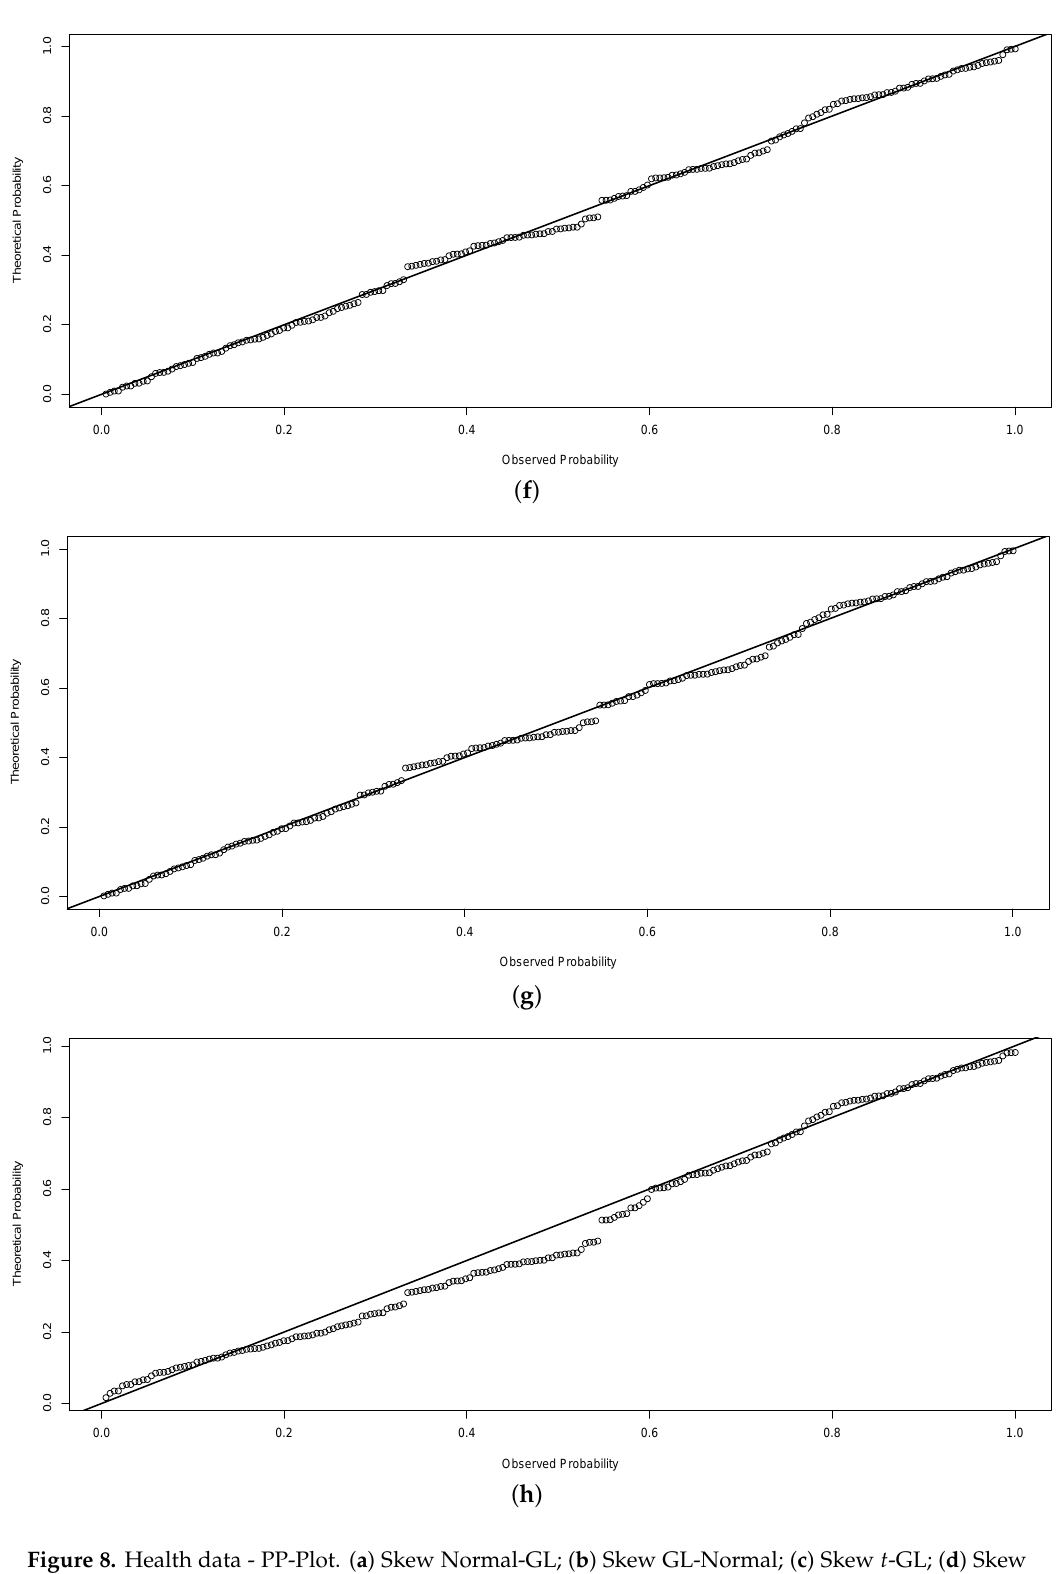
Figure 8. Health data - PP-Plot. ( a ) Skew Normal-GL; ( b ) Skew GL-Normal; ( c ) Skew t -GL; ( d ) Skew GL- t ; ( e ) Skew Normal-Logistic; ( f ) Skew Logistic-Normal; ( g ) Skew t -Logistic; ( h ) Skew Logistic- t